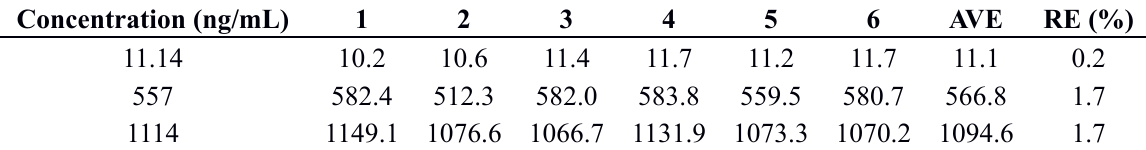
Table 9. Unpreparative stabilities at room temperature for 24 h ( n =